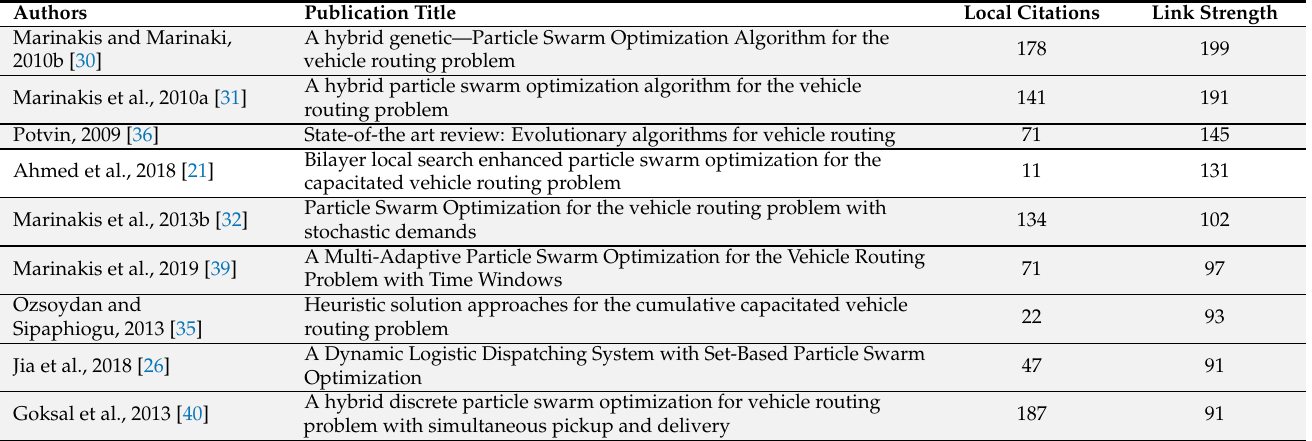
Table 6. Key PSO/VRP documents from the Scopus query that are bibliographically coupled, n =